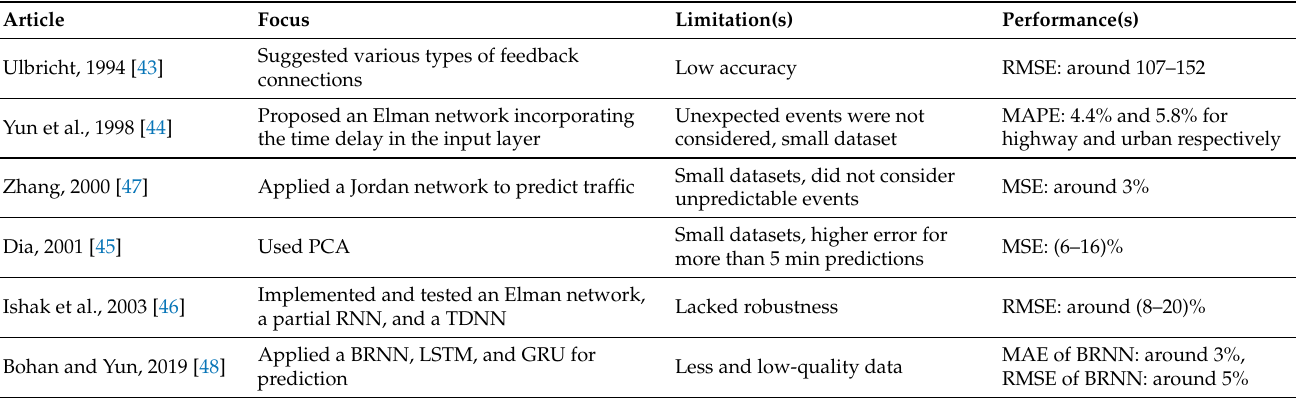
Table 5. Summary of the works found using